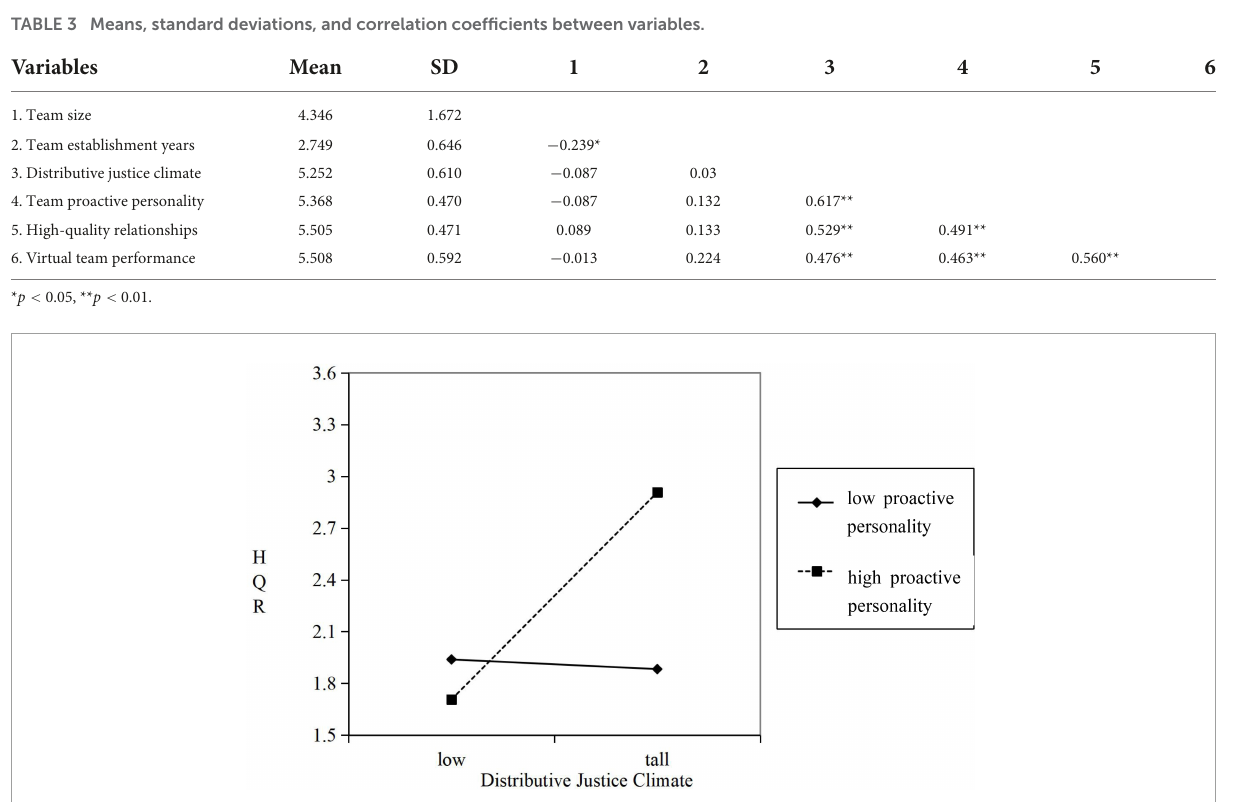
FIGURE2 Moderated mediating effect of team proactive personality. HQR, high-quality